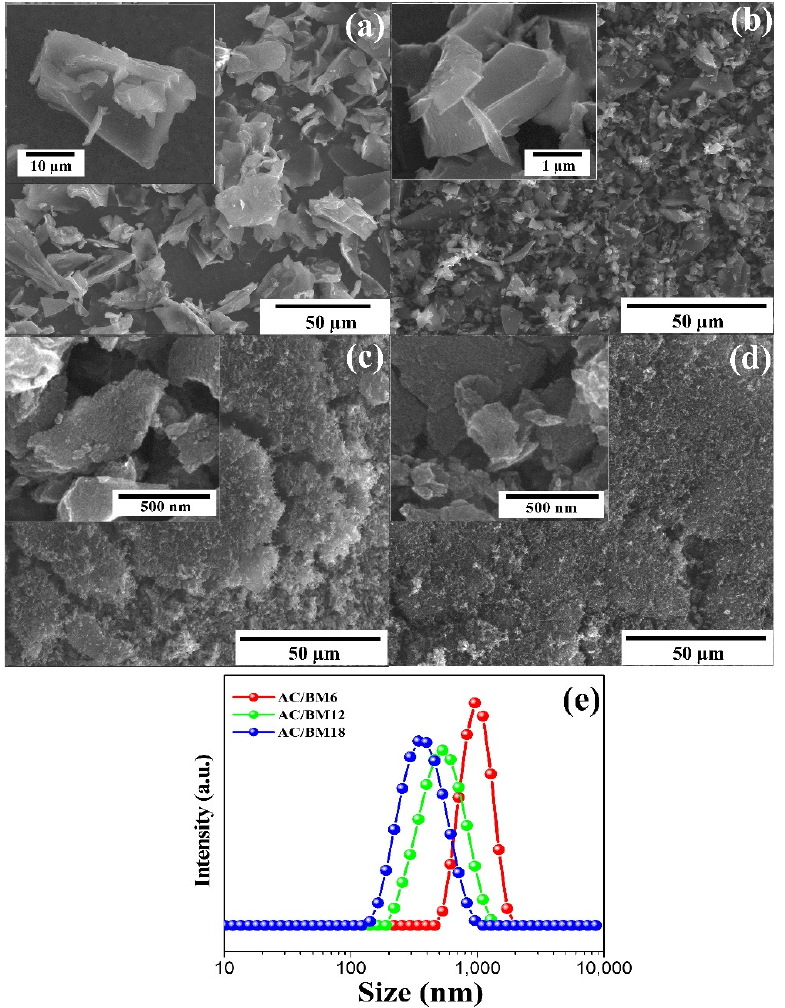
Figure 3. FESEM images of ( a ) AC, ( b ) AC/BM6, ( c ) AC/BM12, ( d ) AC/BM18 and ( e ) Zeta nanoparticle size analysis of AC/BM6, AC/BM12 and AC/BM18.